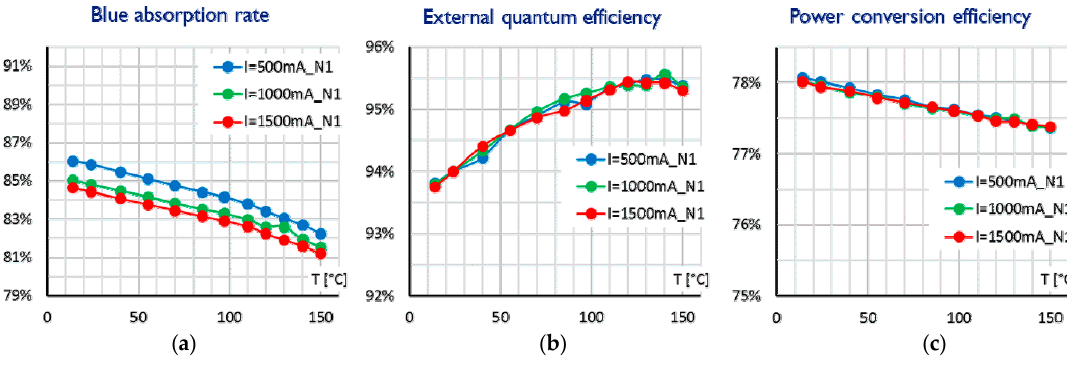
Figure 9. Measured temperature dependence of ( a ) the blue absorption rate, ( b ) the external quantum efficiency, and ( c ) the power conversion efficiency for a phosphor sample prepared from one of the commercially available phosphor powders.